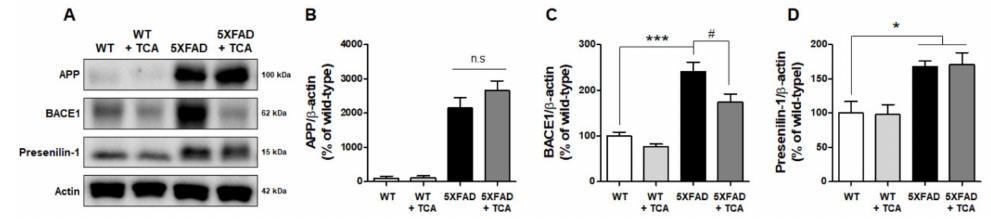
Figure 4. TCA decreases β -secretase (BACE1) levels in the brains of 5XFAD mice. ( A ) Representative immunoblotting for amyloid precursor protein (APP), BACE1, and presenilin1 (PS1) in brain